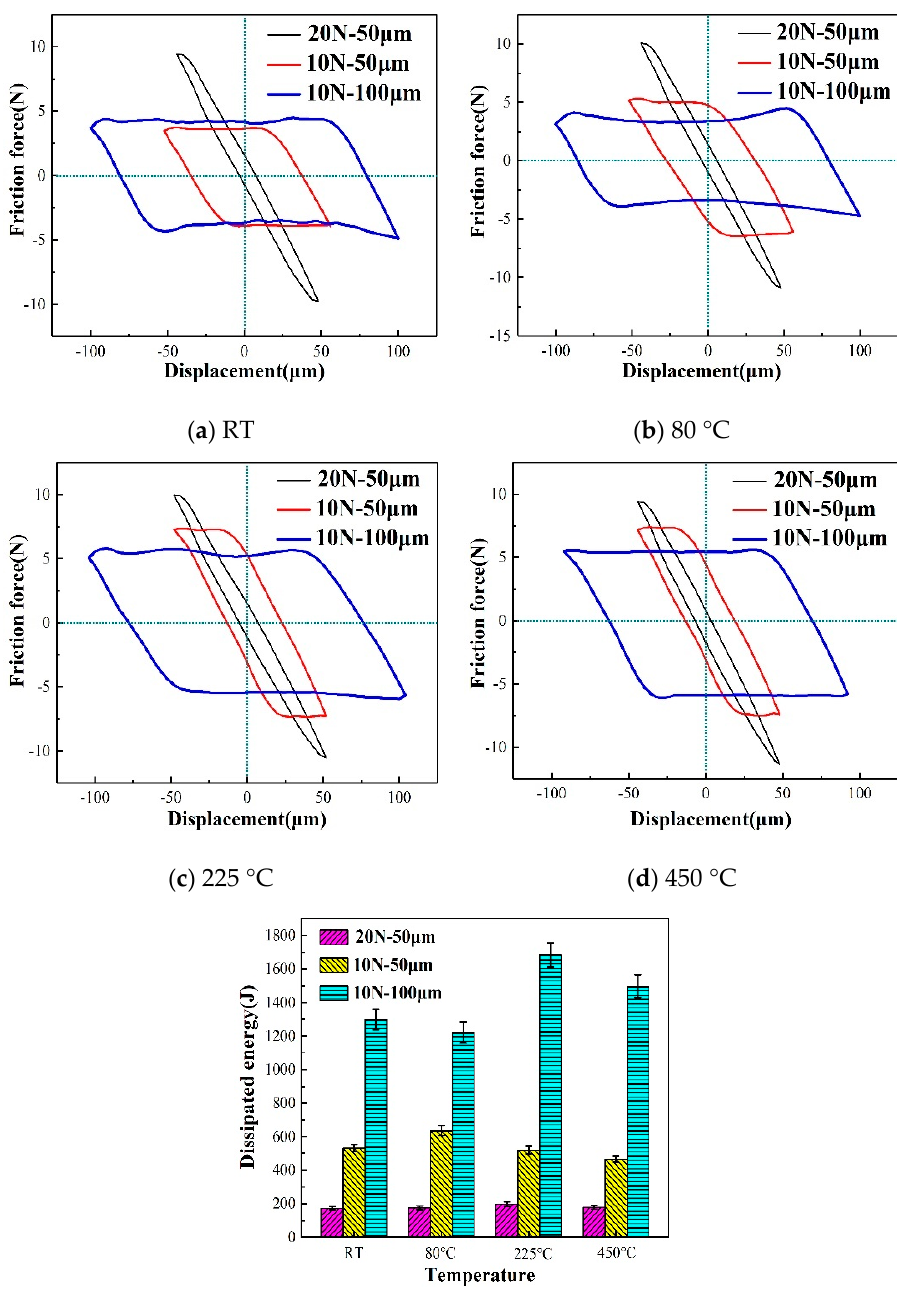
Figure 3. Ft–D curves ( a – d ) and dissipated energy ( e ) with varied temperatures, cycles = 10 4 .